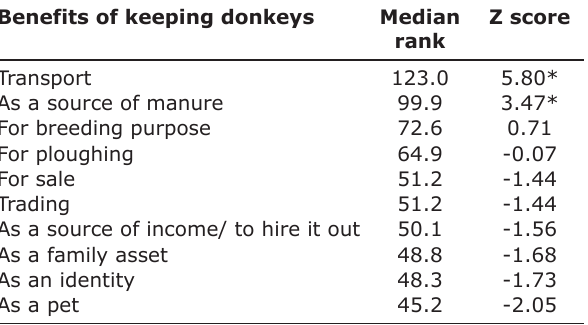
Table-1: Benefits of keeping donkeys according to smallholder farmers in Kirinyaga County from June to